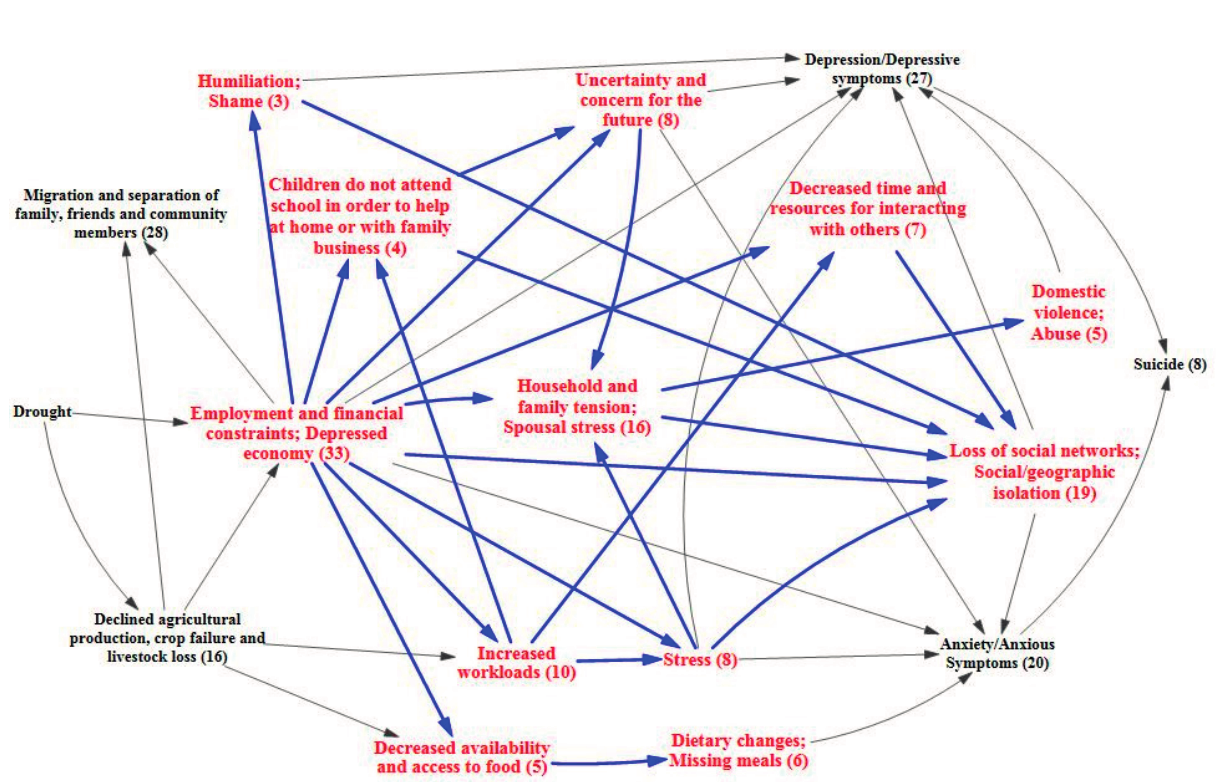
Figure 2. Direct economic effects of drought.